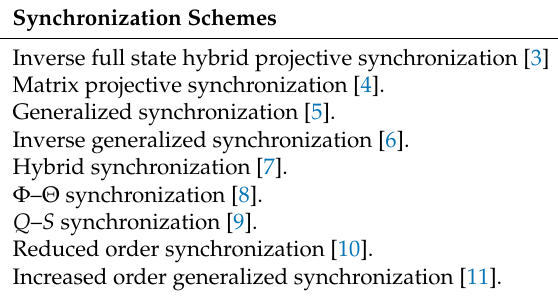
Table 1. Synchronization schemes for integer-order systems with different